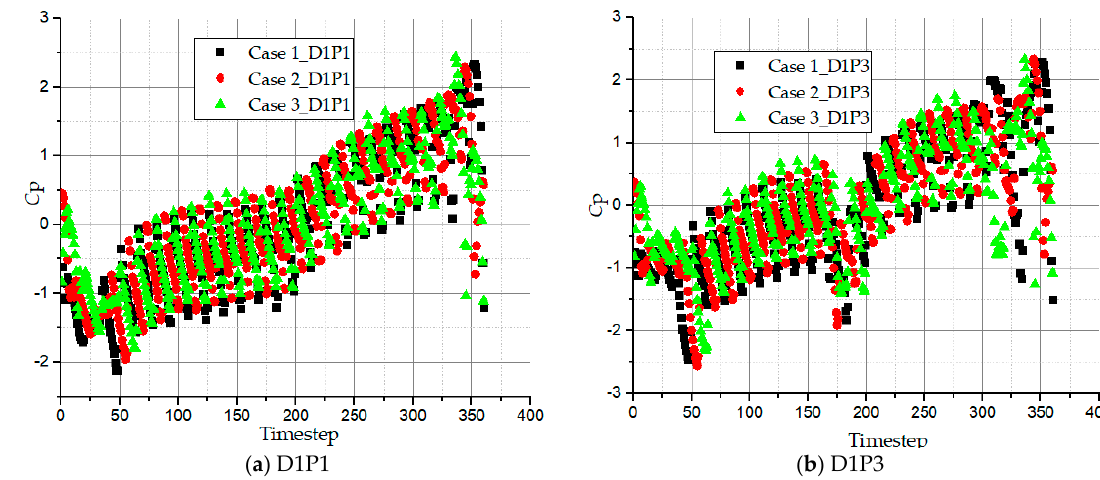
Figure 17. Time domain history of pressure fluctuation coefficient in impeller passage at interrupter region for all pump cases.